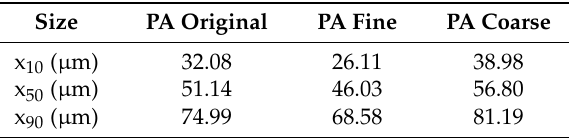
Table 1. Specific particle sizes of the fractions.